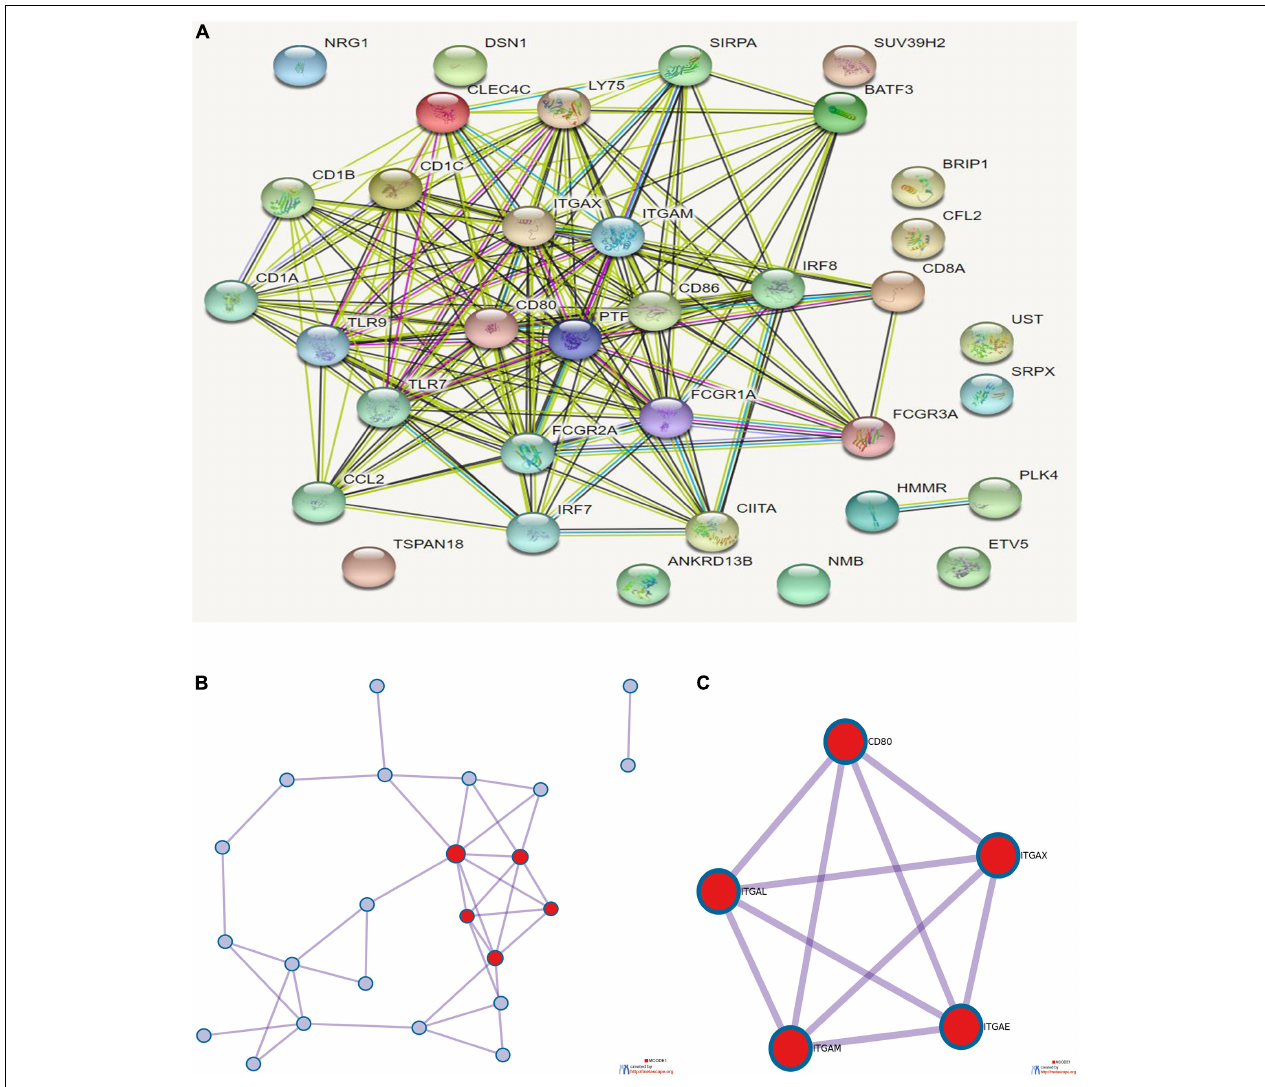
FIGURE 9 | (A) Protein interaction analysis results of prognostic-related genes. (B) Topological network of protein interaction analysis results. (C) Core genes screened by protein interaction analysis. qPCR detection of the seven core RNAs in phases I and III and differential expression in tissues of patients with colon cancer and normal